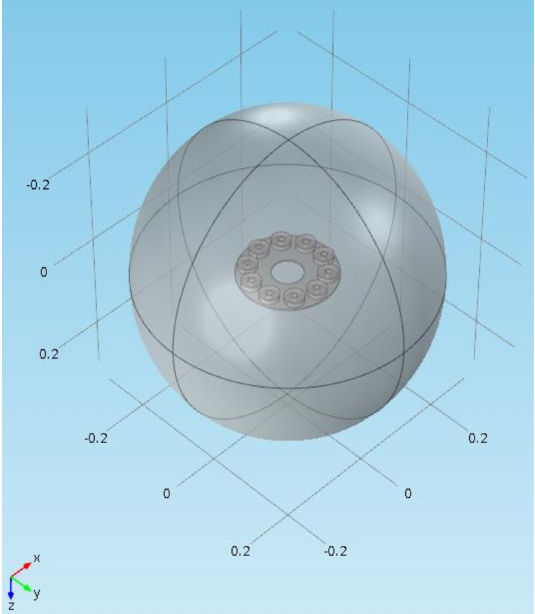
Figure 3. Computational domain in